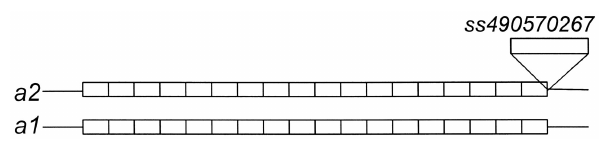
FIGURE 2 | Size variation between the alleles of D9BrapaS1 in RCBr is due to a single insertion ss490570267 .